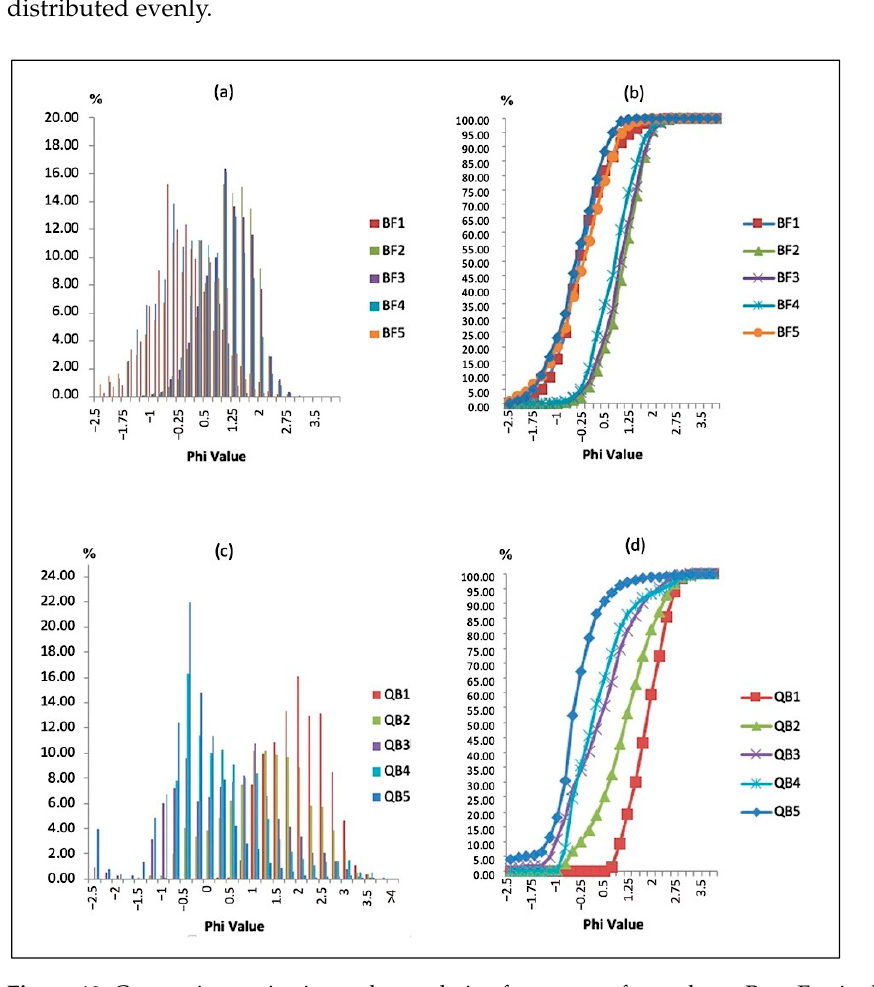
( b ) Figure 11. Comparison between ( a ) lithology map (modified from [40]) and ( b ) geomorphology map of the overall Penang Island. Both sites are beach landforms. Symbol 1 and 2 represent the survey site 1 and survey site 2.